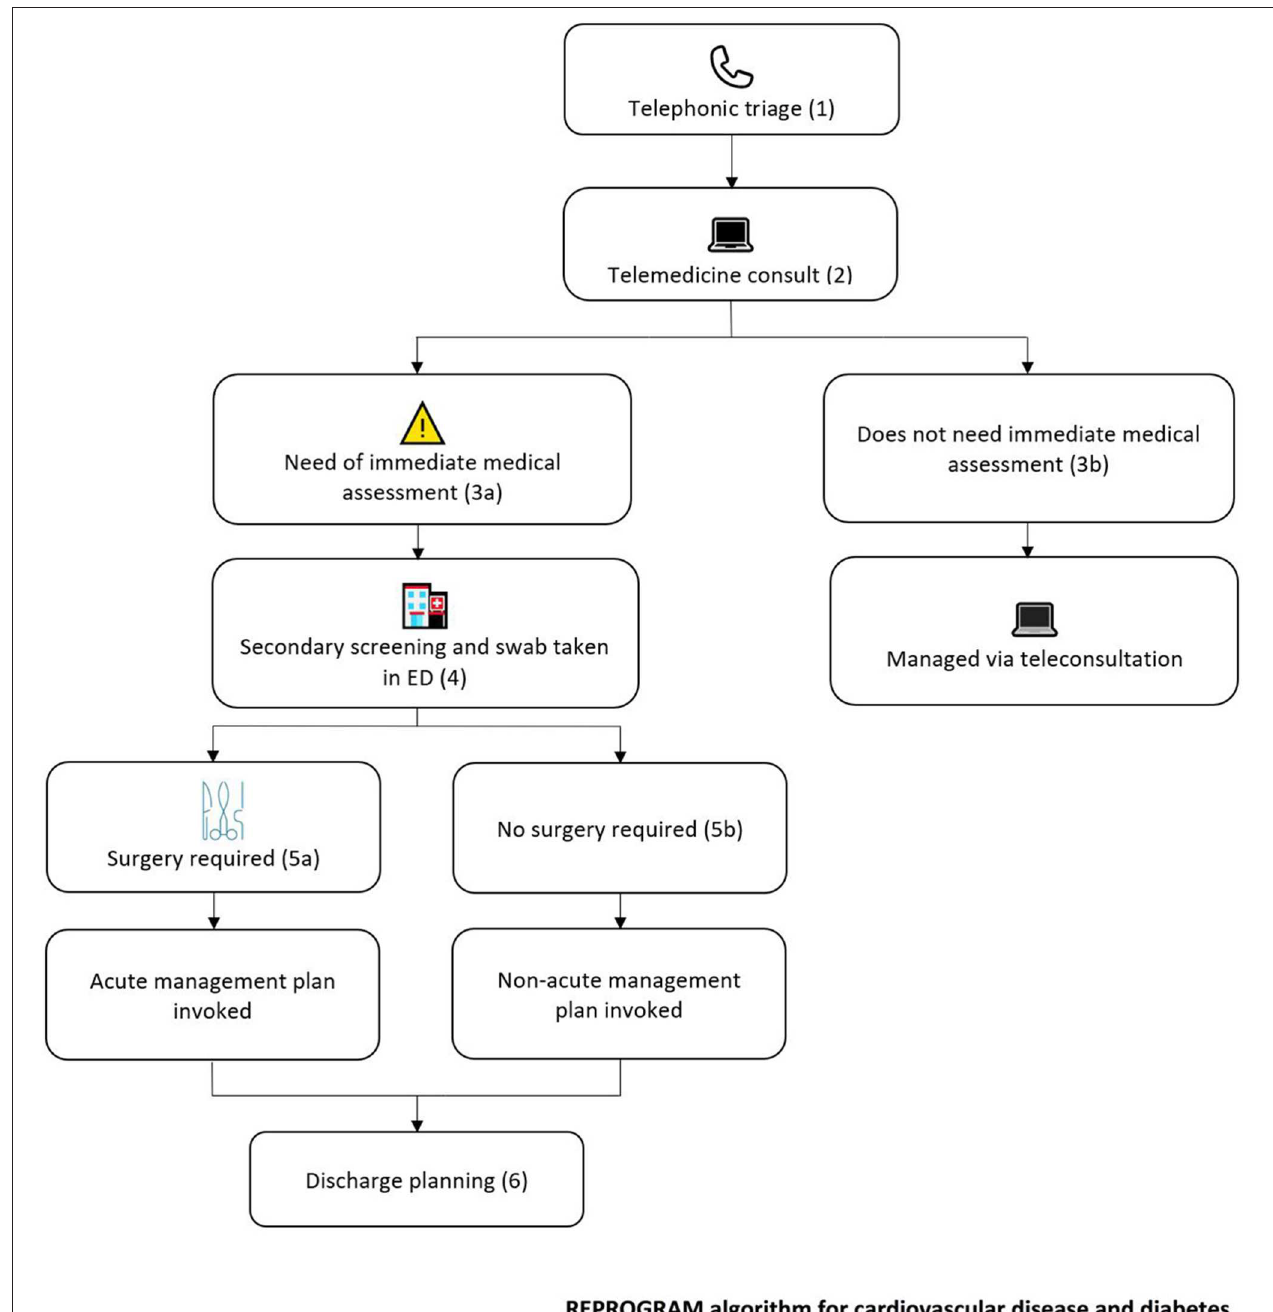
FIGURE 1 | Proposed cardiovascular disease and diabetes risk-adjusted, stage-wise, tele and in-hospital triage and management protocol. (1) All patients seeking outpatient or in-hospital appointment, except the emergency cases, must dial into the hospital for a triage over telephone for risk assessment of COVID-19 cases prior to consultation. The triage will be carried out by the relevant department officer, and will comprise a brief screening for signs, symptoms, and risk factors of COVID-19. Questions should address recent travel history, fever, cough, sore throat, shortness of breath, fatigue, aches and pains, headaches, runny or stuffy nose, diarrhea, sneezing, and loss of smell. Patients should be screened for their body mass index (BMI) and those with BMI ≥ 30 should be closely monitored and strongly advised to self-isolate and follow public health guidelines. Patients with BMI ≥ 30 are at significant risk of mortality after COVID-19 infection. (2) All patients, despite risk factors and symptoms, should be asked to attend a compulsory teleconsultation in order to minimize harm to both the patient and consultant. During the consultation, further assessment of COVID-19 symptoms can be made, and potential impact on underlying diabetes/cardiovascular disease should be assessed. (3a) Should there be a self-reported acute emergency by the patient, or a need for immediate medical attention as per the clinical judgement of the physician, the patient should be asked to